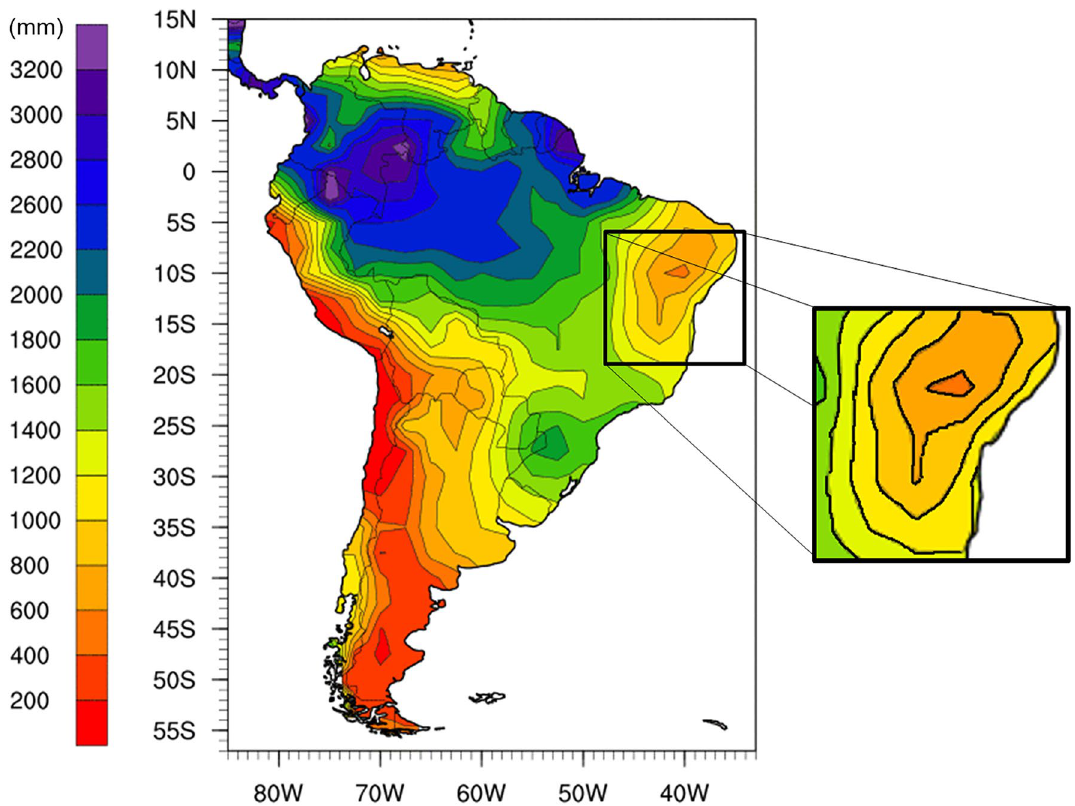
Figure 1. Annual total precipitation in Bahia. According to the Physical Science Division of U.S. department of commerce between 1976 and 2009 this was less than 1000 mm. Figure adapted from 15